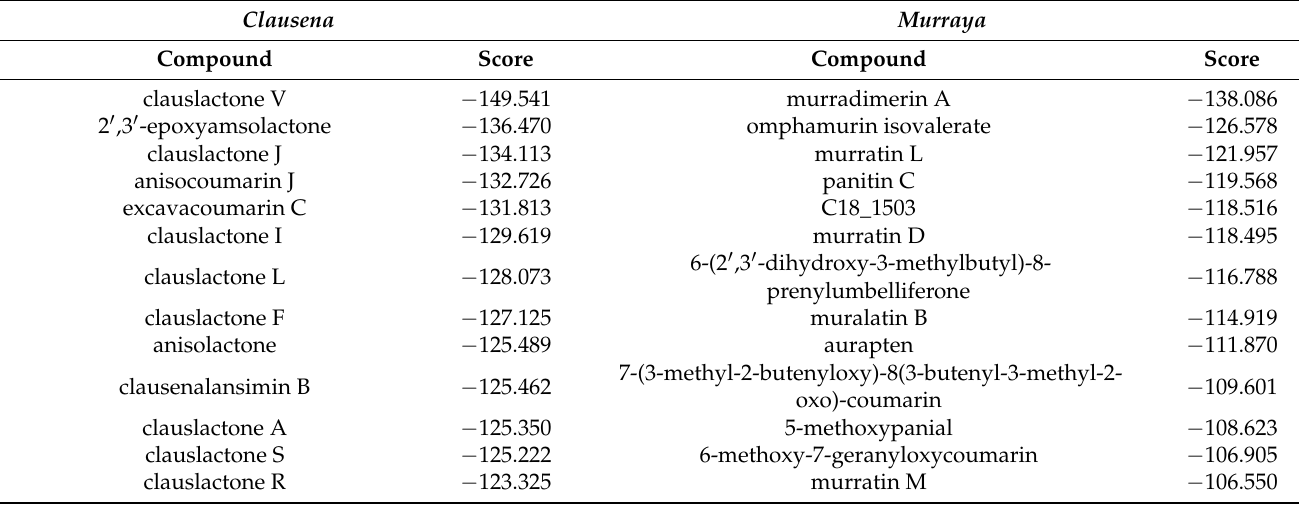
Table 1. Docking results of coumarins in Clausena and Murraya